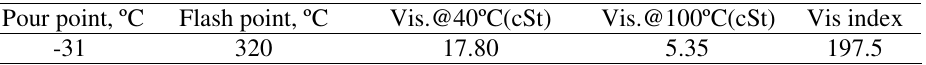
Table 4. Physical properties of oleylolate